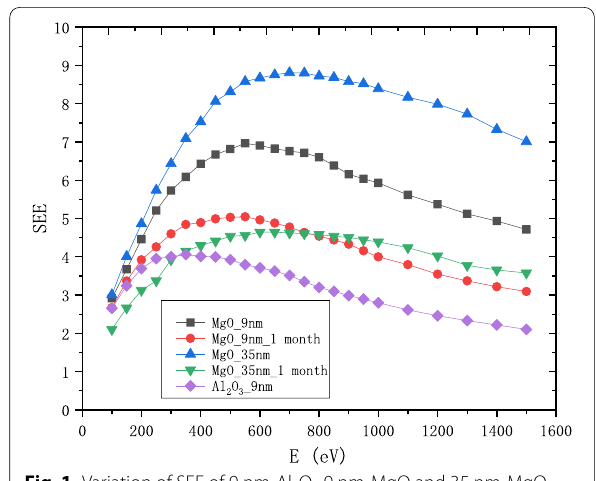
Fig. 1 Variation of SEE of 9 nm-Al 2 O 3 9 nm-MgO and 35 nm-MgO with the incident electron energy, and the result measured after 1 month of air deliquescence of the